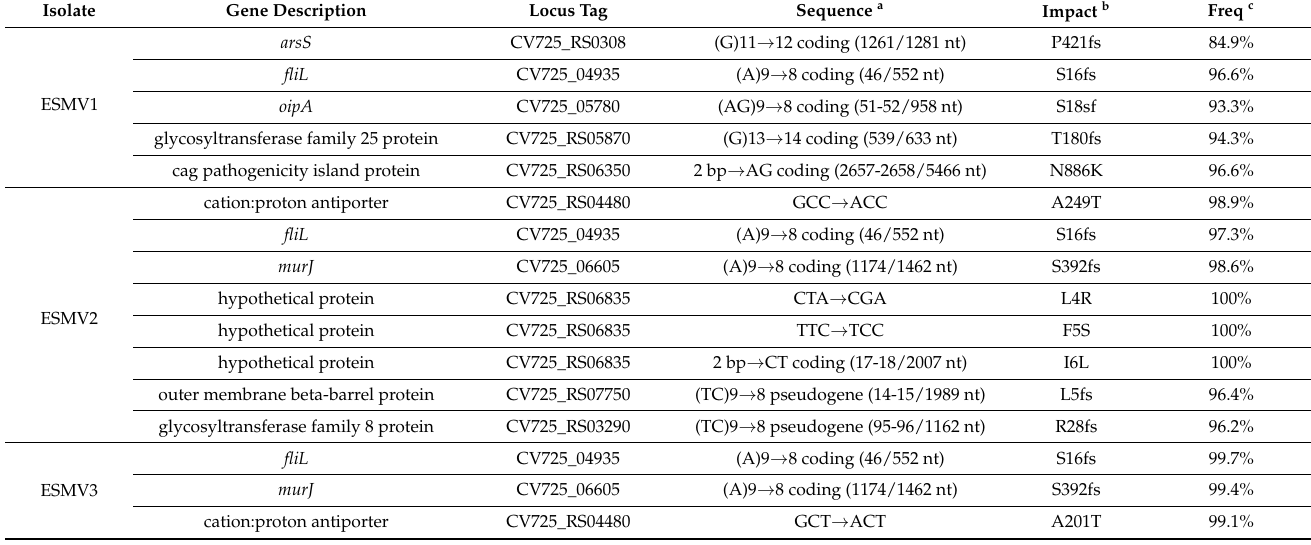
Table 3. Identified intragenic mutations in the ∆ hp1487 / hp1486 motile